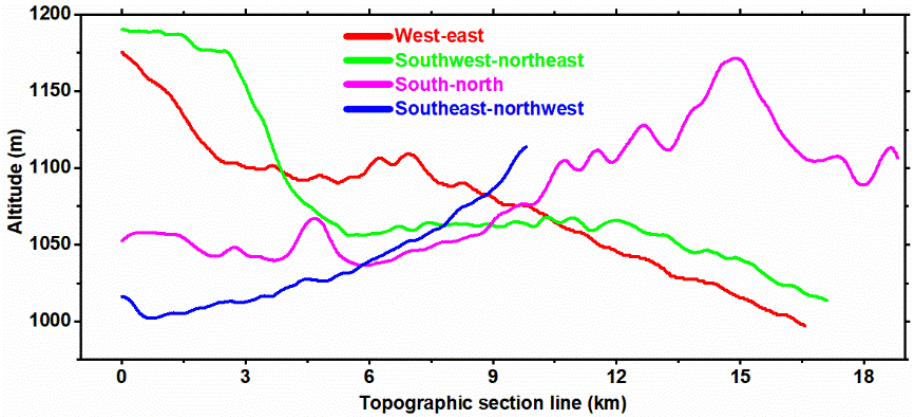
Figure 5. Topographic profile of the study area along the sampling line.